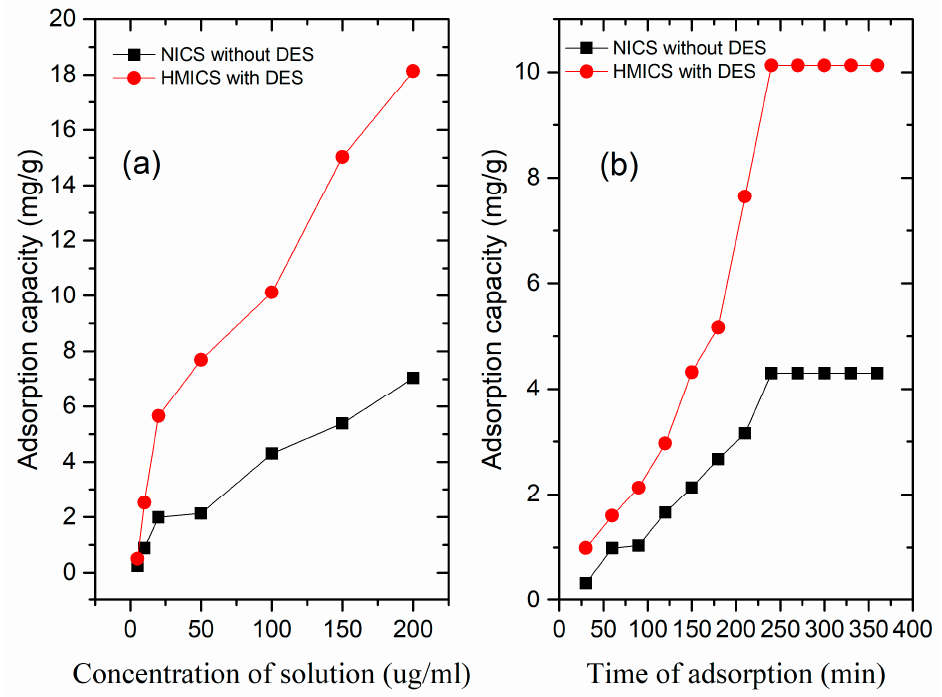
Figure 3. Equilibrium adsorption isotherms ( a ) and kinetic adsorption curves ( b ) of HMICS with DES, and non-imprinted chitosan (INCS) without DES.